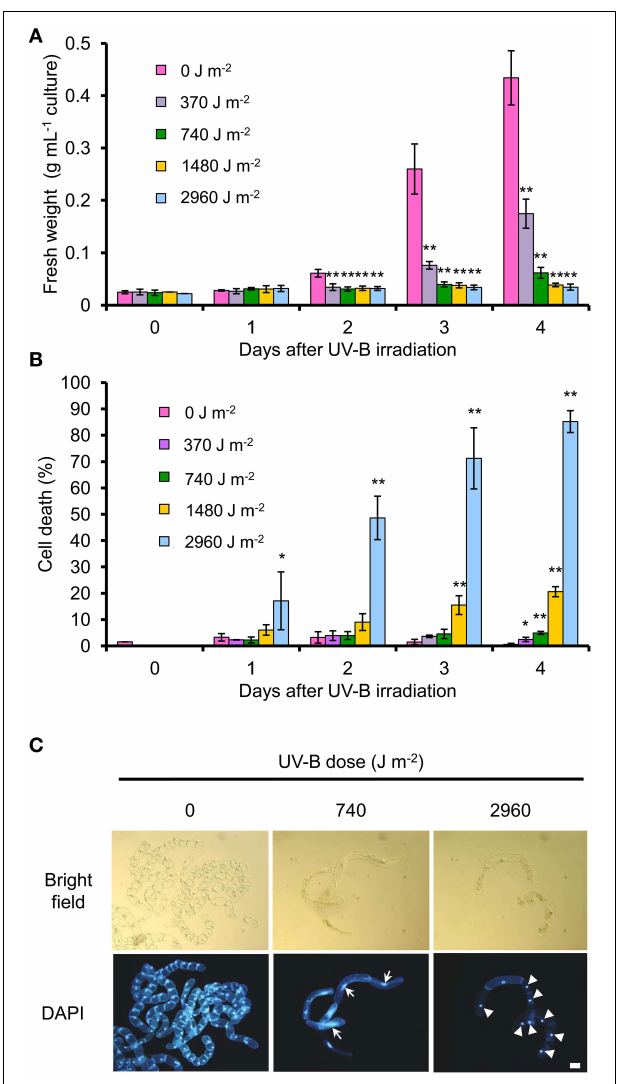
FIGURE 1 | Effect of UV-B radiation on cell proliferation and cell death. BY-2 cells were irradiated with UV-B (0–2960 J m − 2 ) and cultured for 4